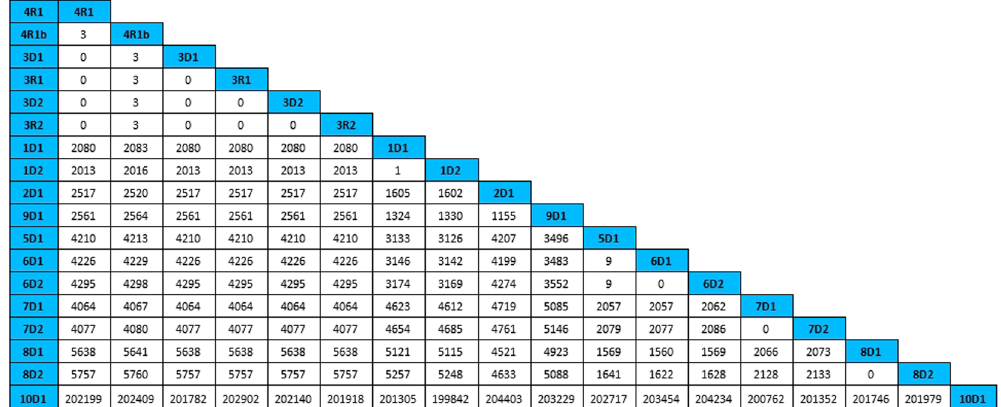
Figure 2. Mutations identified by genome comparison between every two A.baumannii isolates. Isolate 10D1 has a much larger genome than that of the other isolates, so are the numbers of SNVs between it and other isolates. Result of BLAST suggested that it was identical to the type genome of Acinetobacter nosocomialis .